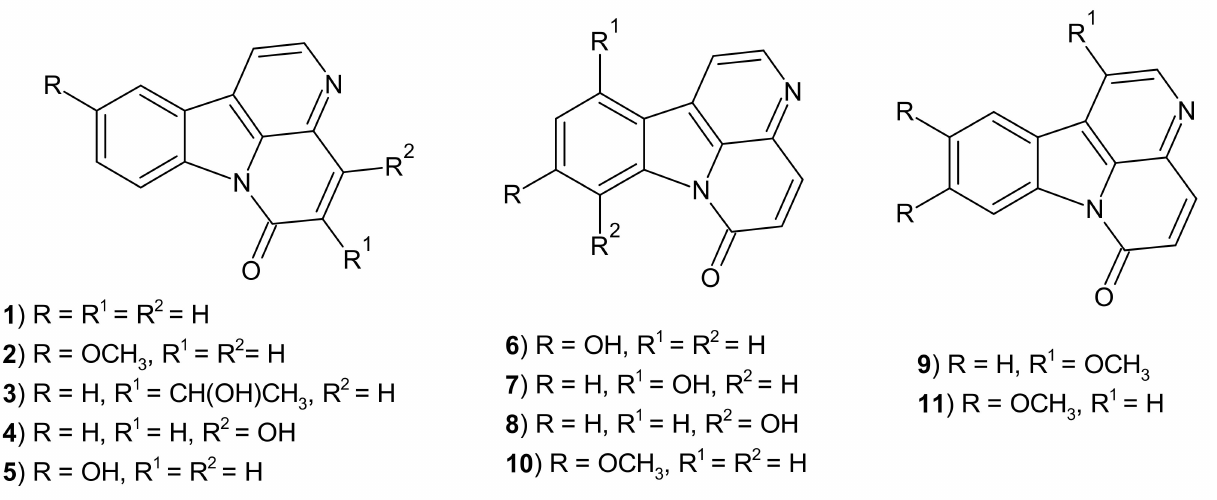
Figure 2. Structure of canthin-6-one